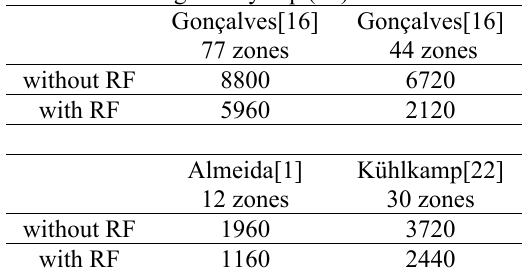
Table 12 – Mean number of function evaluations given by Eq. (15).